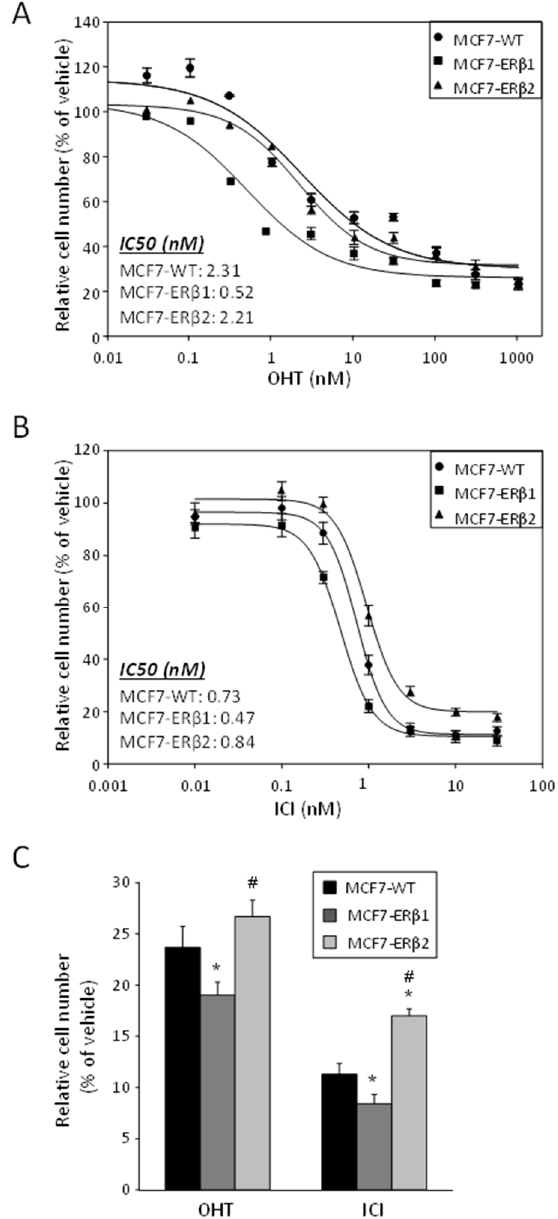
Figure 2. ER β 1 and ER β 2 inversely affect the antiproliferative efficacy of OHT and ICI. ( A , B ) Proliferation of MCF7-WT, MCF7-ER β 1 and MCF7-ER β 2 cells treated with vehicle (0.1% DMSO), increasing concentrations of OHT ( A ) or increasing concentrations of ICI182,780 ( B ) for six days. Relative cell numbers were expressed as percentage of the cell number of vehicle-treated cells. Plots are representative of at least three independent experiments carried out in triplicate. ( C ) Proliferation of MCF7-WT, MCF7-ER β 1 and MCF7-ER β 2 cells treated with vehicle (0.1% DMSO), ICI (30 nM) or OHT (300 nM) for six days. Relative cell numbers were expressed as percentage of cell number of vehicle-treated cells. Values are mean ± SEM of at least three independent experiments carried out in triplicate. * p < 0.05 vs. MCF7-WT, # p < 0.05 vs. MCF7-ER β 1 ( t -test). OHT, 4-hydroxytamoxifen; ICI, ICI182,780.